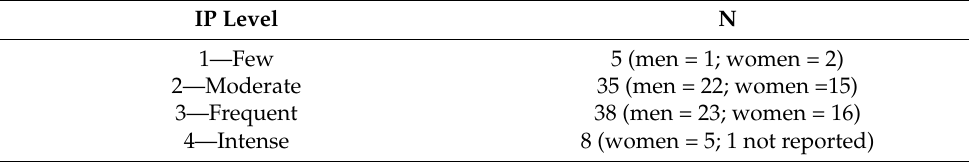
Table 1. Numbers of Students in the Different IP Categories. IP